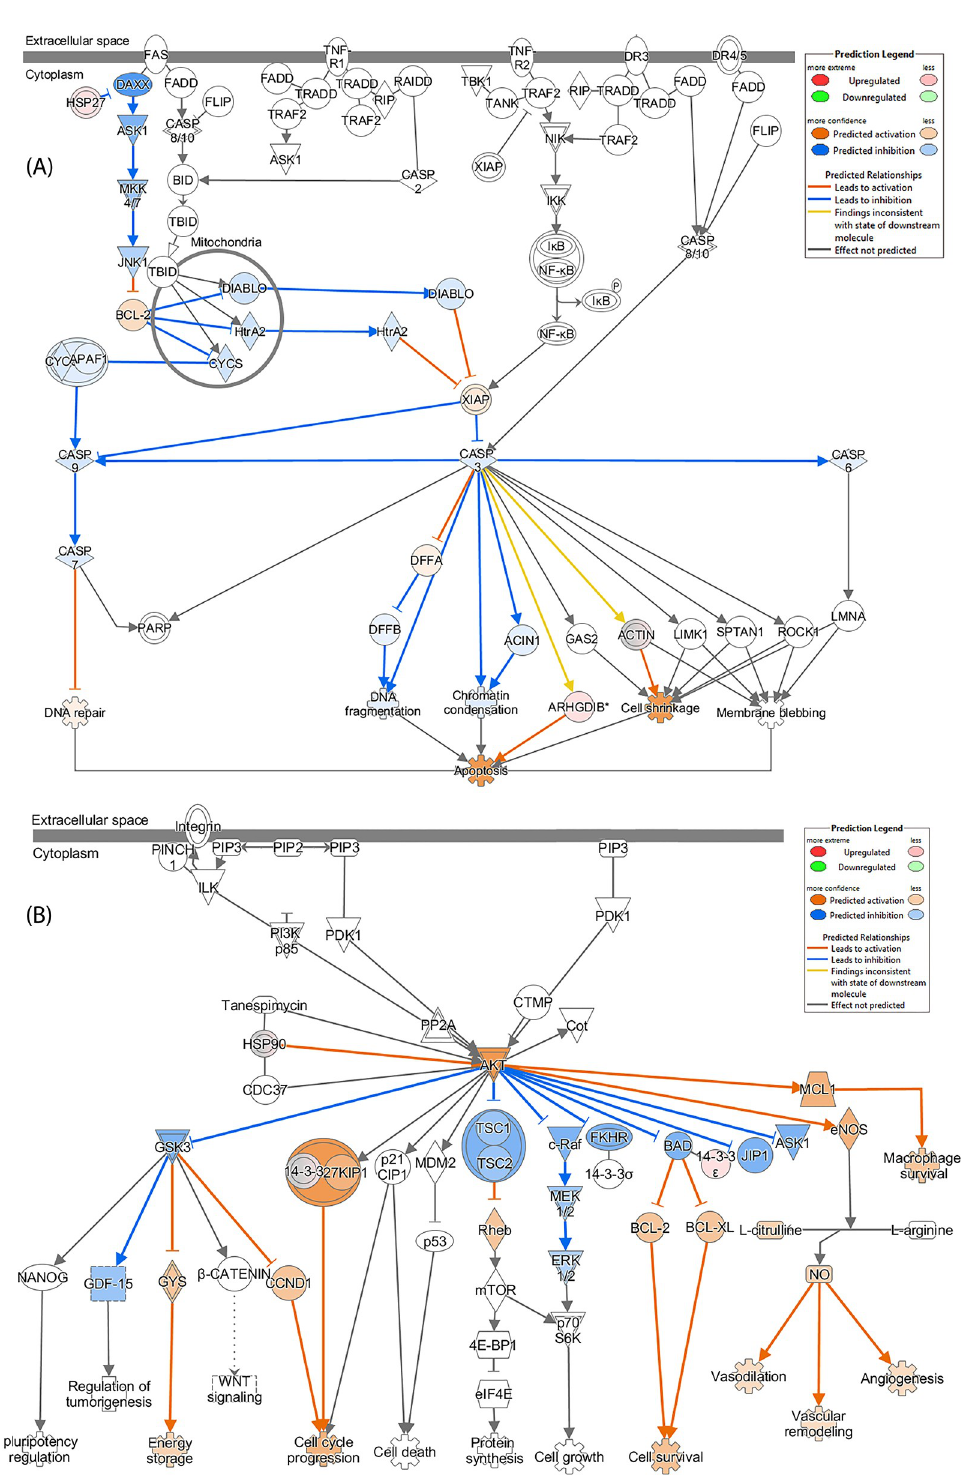
Fig 5. IPA identified the death receptor and PI3K/AKT signalling pathways as the canonical pathways in the U937 cells with the highest predicted potential/significance affected by the treatments with LPS+anti-IL10 and LPS+anti- IL10R antibodies, respectively, predicted based on iTRAQ-label quantitation. (A) the modulation of the death receptor signalling pathway by LPS+anti-IL10 antibody and (B) the modulation of the PI3K/AKT signalling pathway by LPS+anti-IL10R antibody. The up-/down-regulations of proteins are indicated by nodes with a range of red and green